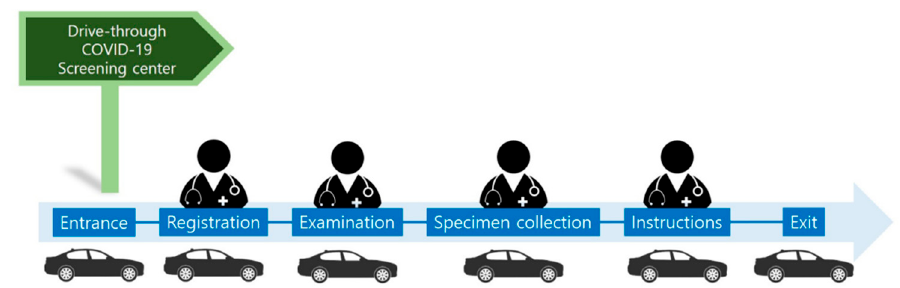
Figure 4. Schematic illustration of a drive-through screening center for COVID-19 testing.